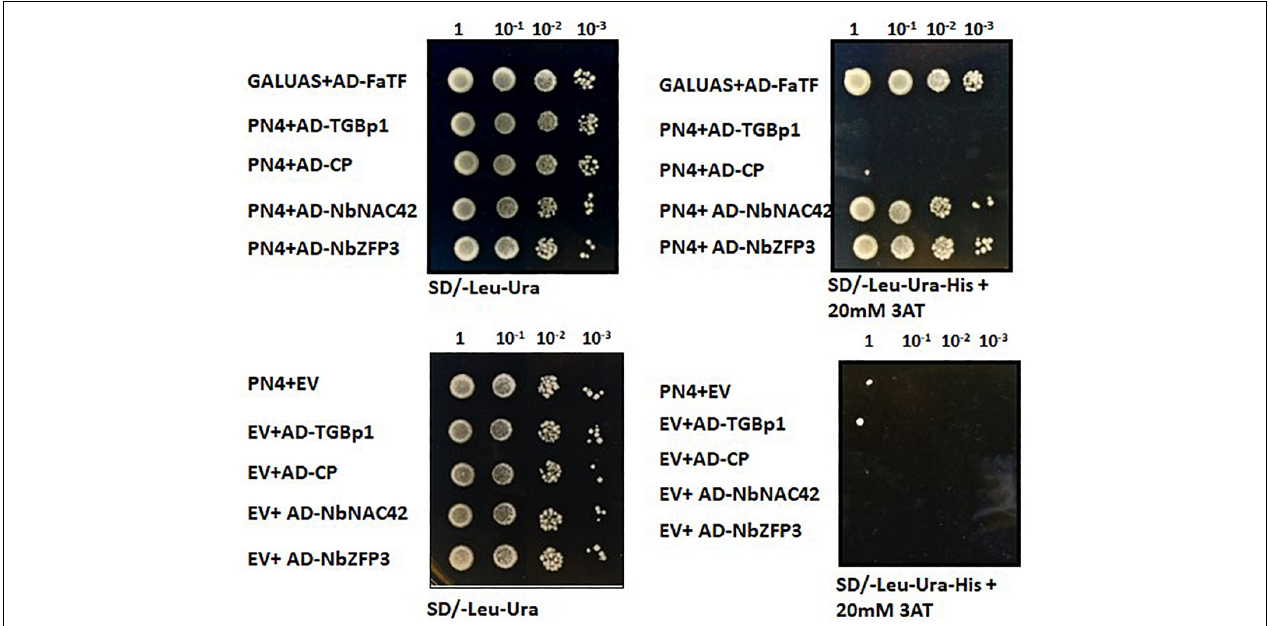
FIGURE 5 | Yeast one-hybrid assay for the interaction between NbAGO5 promoter (704 bp) and transcription factors or BaMV proteins. Yeast strain Y187 expressing PN4 (prey) was transformed with pGADT7-CP, pGADT7-TGBp1, pGADT7-NbNAC42, or pGADT7-NbZFP3 (bait). Transformed yeast cells were selected on SD minimal medium without Leu, Ura, and His but containing 20 mM 3-AT. Empty prey and bait vectors were used as negative controls. Coexpression of GALUAS along with FaTF was used as the positive control.